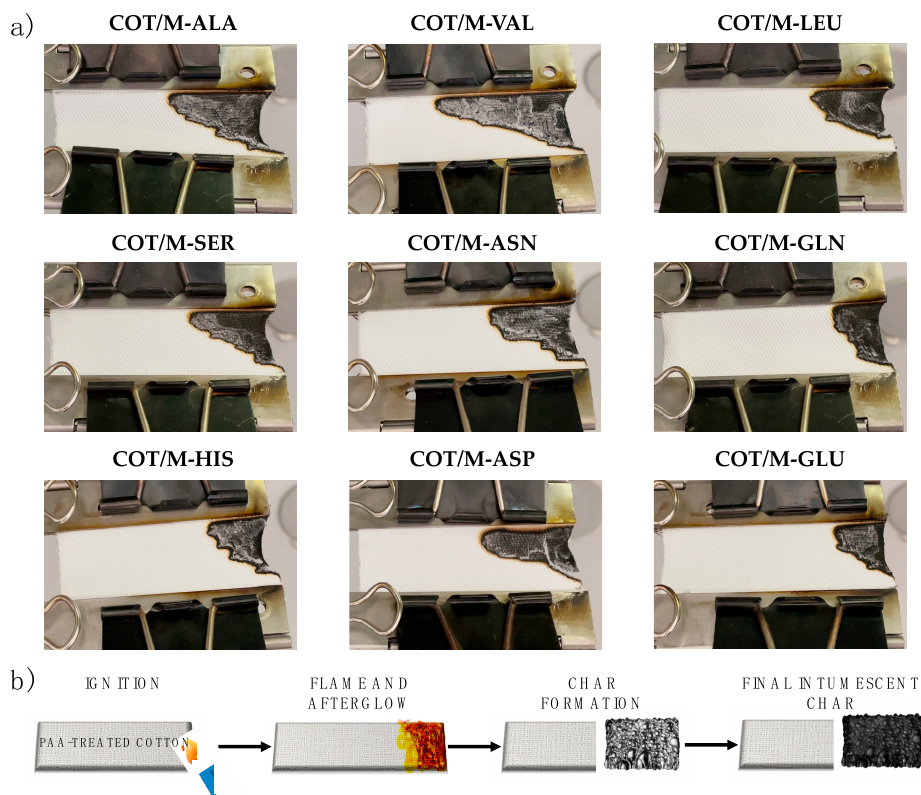
Figure 6. Snapshots of untreated cotton at the beginning and at the end of an HFST ( a ) and of M- GLY-treated cotton with add-ons, 7% and 5%, at the end of an HFST ( b ).